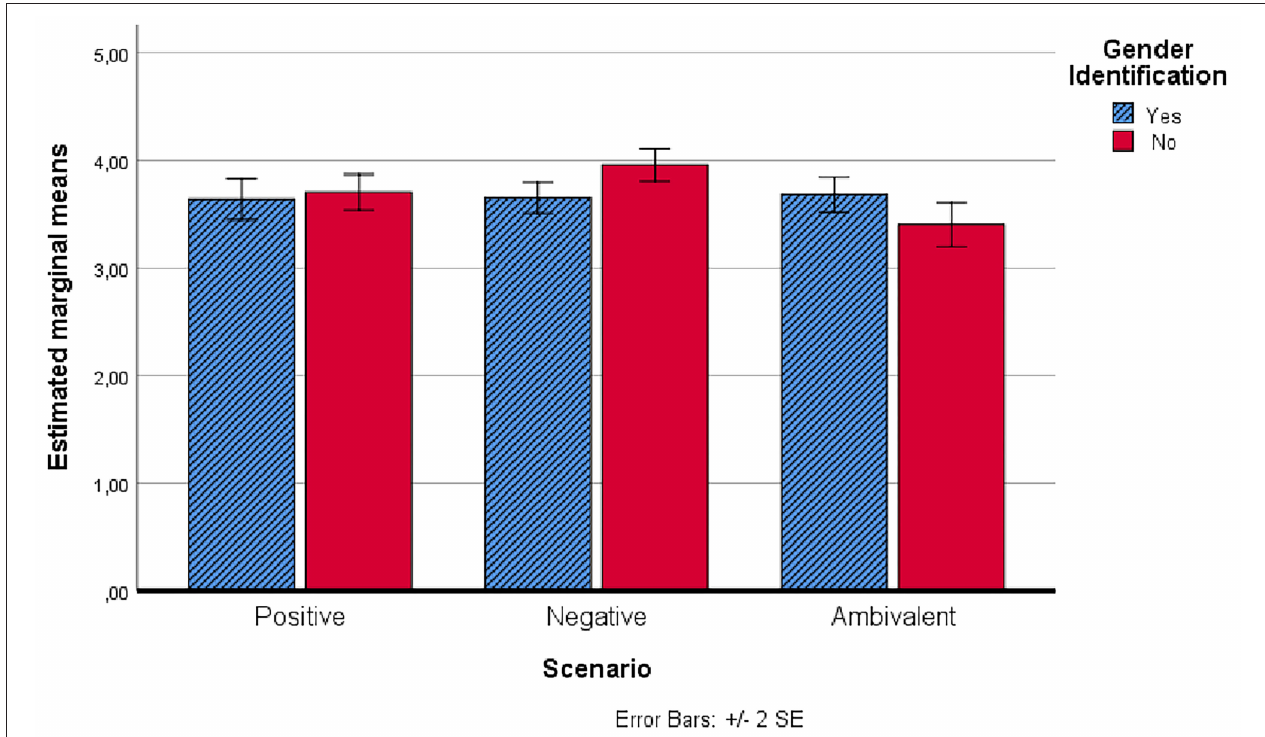
FIGURE 1 | Estimated marginal means of the intention to carry out a diagnostic test for hepatitis C before the administration of